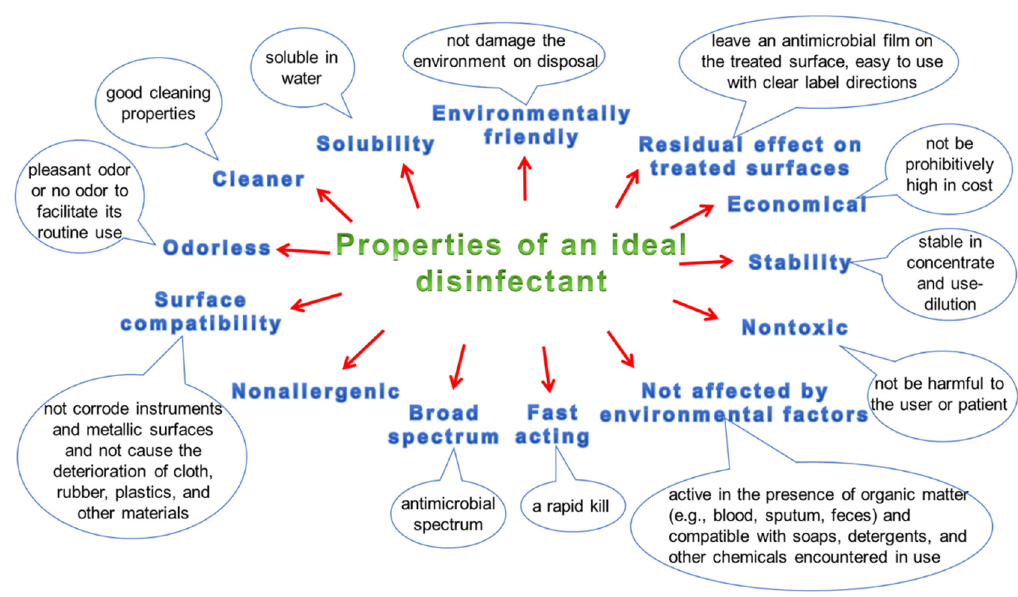
Figure 7. An ideal